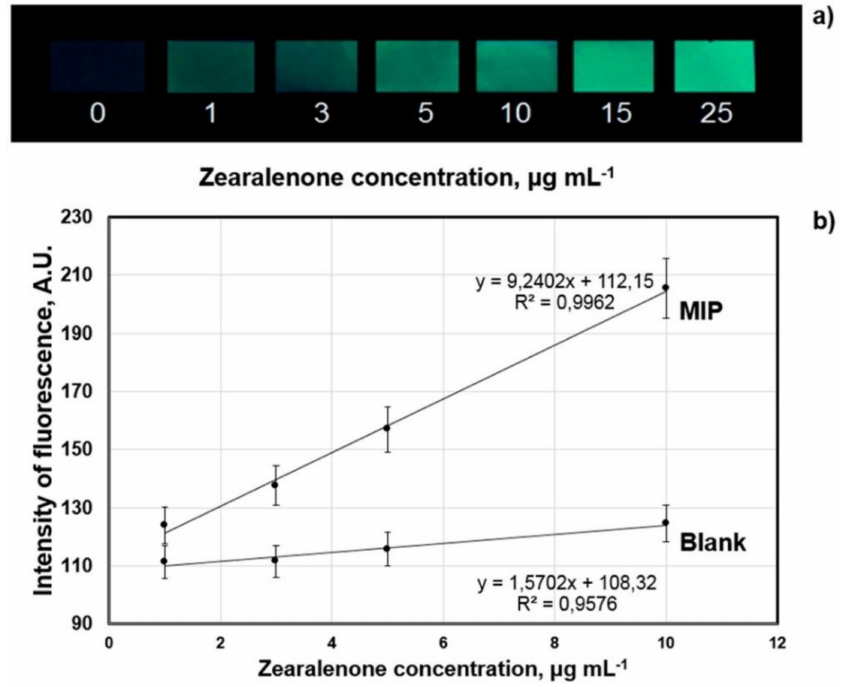
Figure 7. MIP Sensor fluorescence after incubation in zearalenone (1–25 µ g/mL) solutions ( a ); Typical calibration curve of the sensor with smartphone readout system for zearalenone detection ( b );